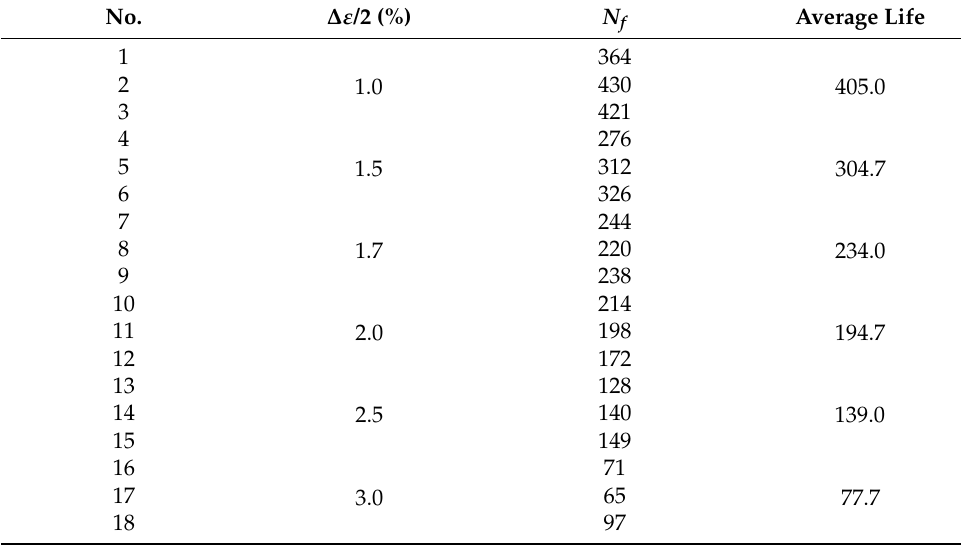
Figure 3. Hysteretic loops of low-cycle fatigue tests with strain amplitudes of: ( a ) 1.0%; ( b ) 1.5%; ( c ) 1.7%; ( d ) 2.0%; ( e ) 2.5%; ( f ) 3.0%. Table 3. Low-cycle fatigue lives of Q345